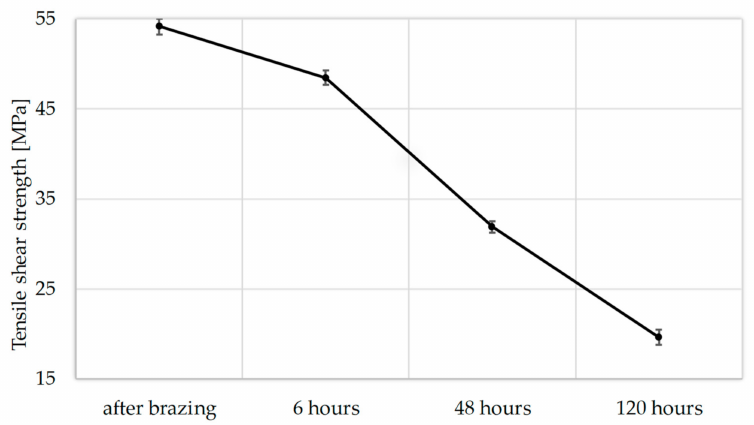
Figure 5. Tensile shear strength of brazed joints depending on the thermal exposure (500 ◦ C)